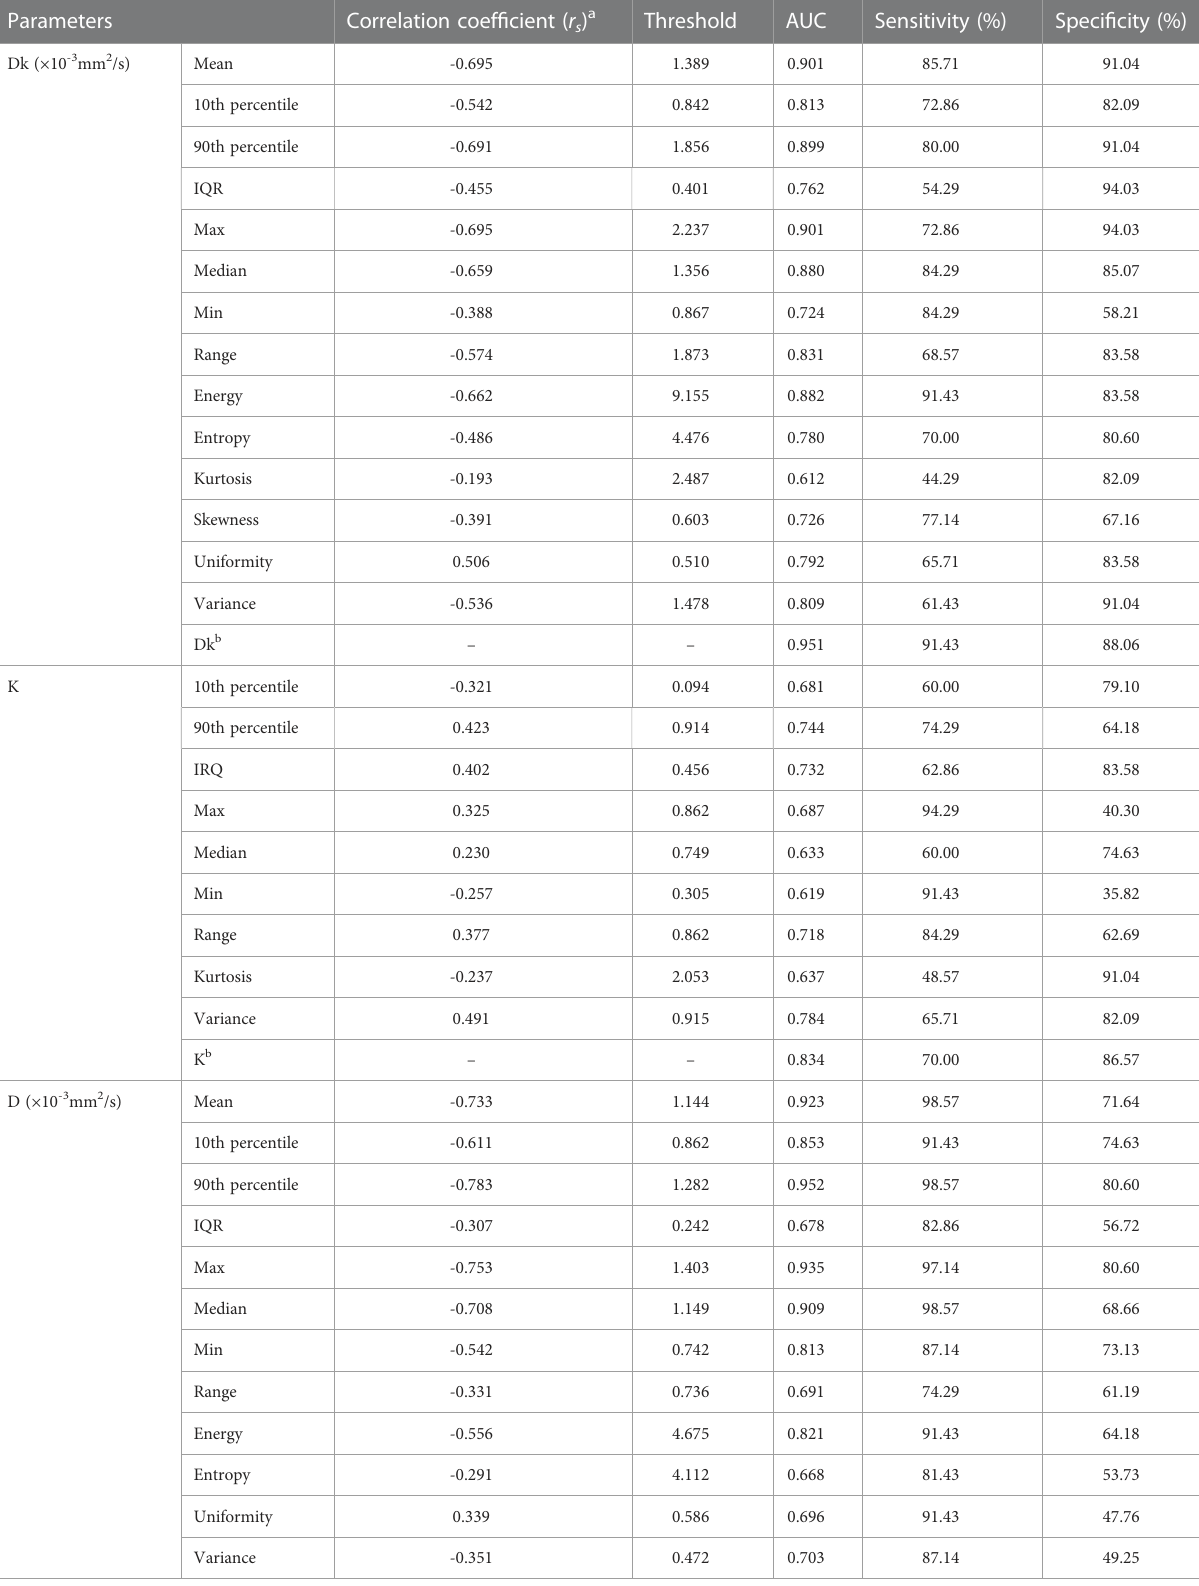
TABLE 2 Correlation analysis of whole-lesion histogram parameters with malignant solitary pulmonary